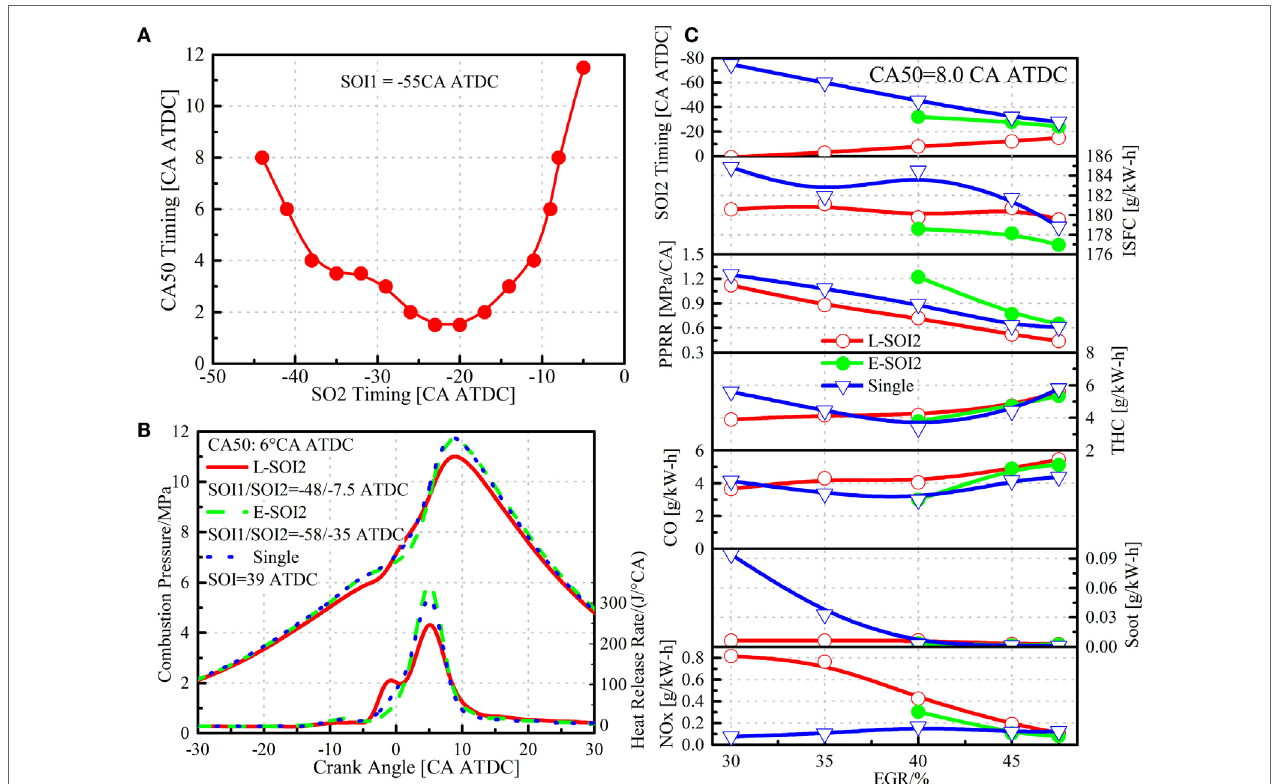
FiGURe 9 | various comparisons among LTC, e-HPCC, and L-HPCC . (A) , CA50 timing as a function of SOI2 timing. (B) , comparison of cylinder pressure and HRR for three injection strategies at the same CA50 of 6 ATDC. (C) , comparisons of three combustion modes in terms of SOI2 timing, PPRR, ISFC, and emissions as a function of